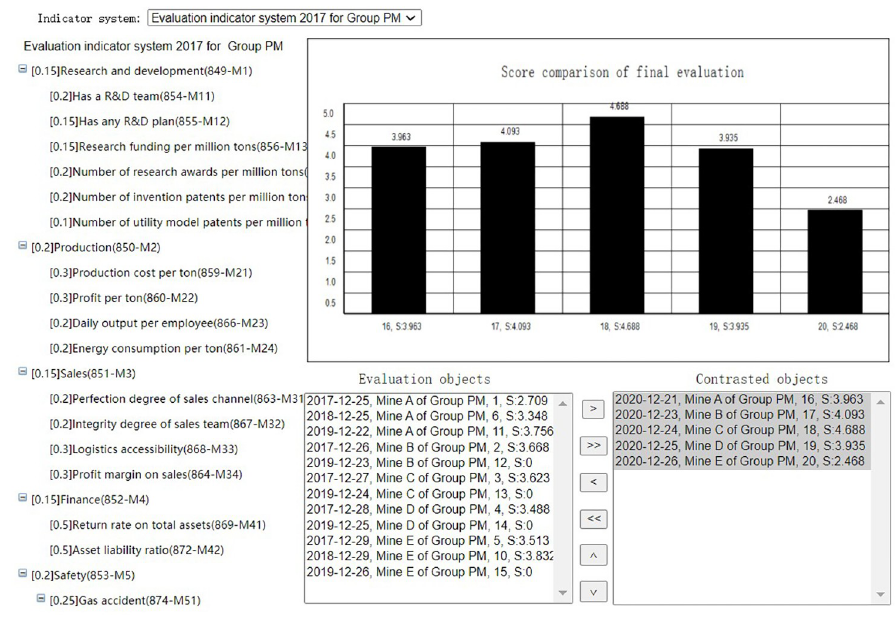
Fig 21. Horizontal score comparison.